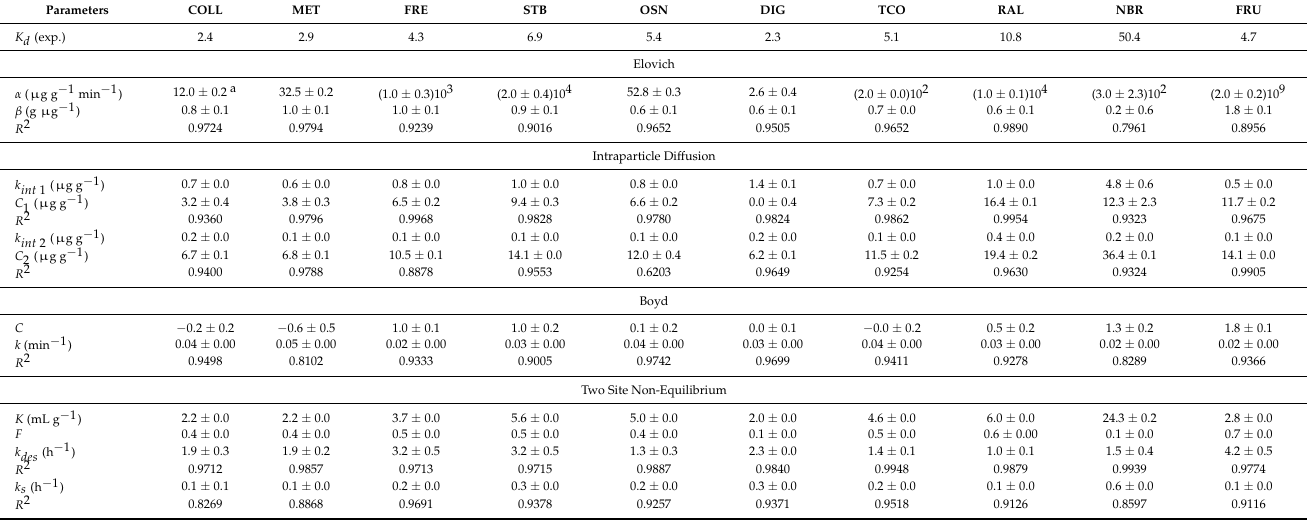
Table 6. Kinetic parameters predicted from the linear analysis of Elovich, Intraparticle Diffusion (IPD), and Boyd models and non-linear analysis for Two-Site Non-Equilibrium model (TSNE). Parameters COLL